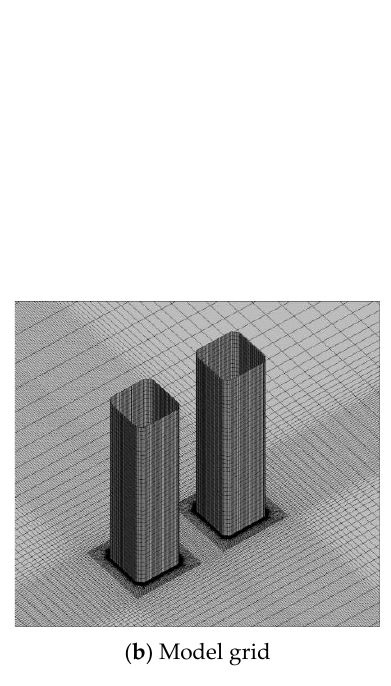
Figure 3. Grid parameters.